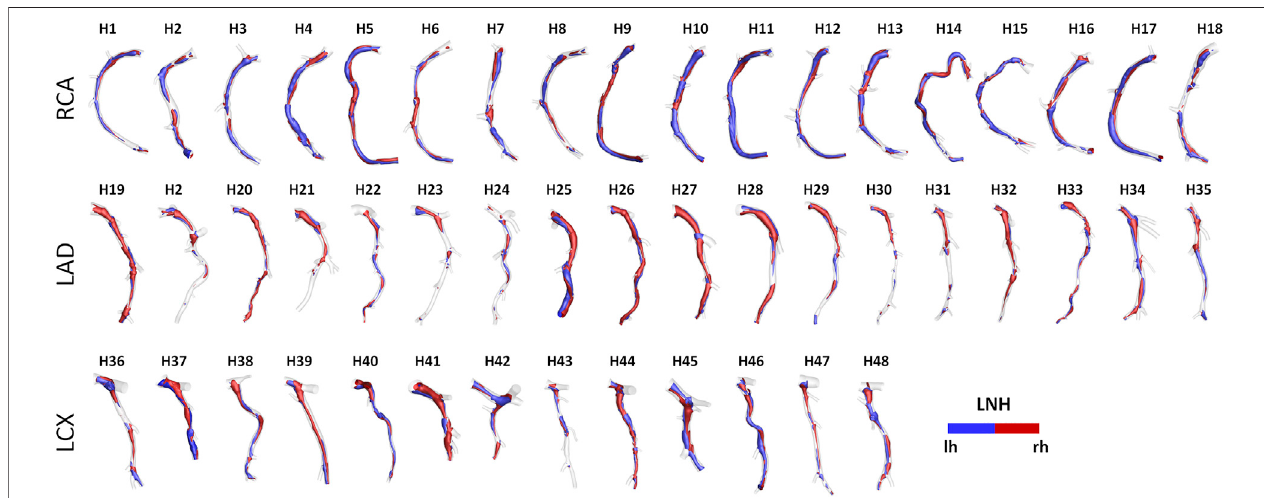
FIGURE 5 | Intravascular fl uid structures in the 49 human coronary arteries. For each case, isosurfaces of cycle-average LNH are presented. Distinguishable left- handed (lh - LNH < 0) and right-handed (rh - LNH > 0) helical fl ow structures can be observed in all coronary arteries. Labels from H1 to H48 identify the single patient. Right (RCA), left anterior descending (LAD), and left circum fl ex (LCX) coronary artery geometries are grouped.